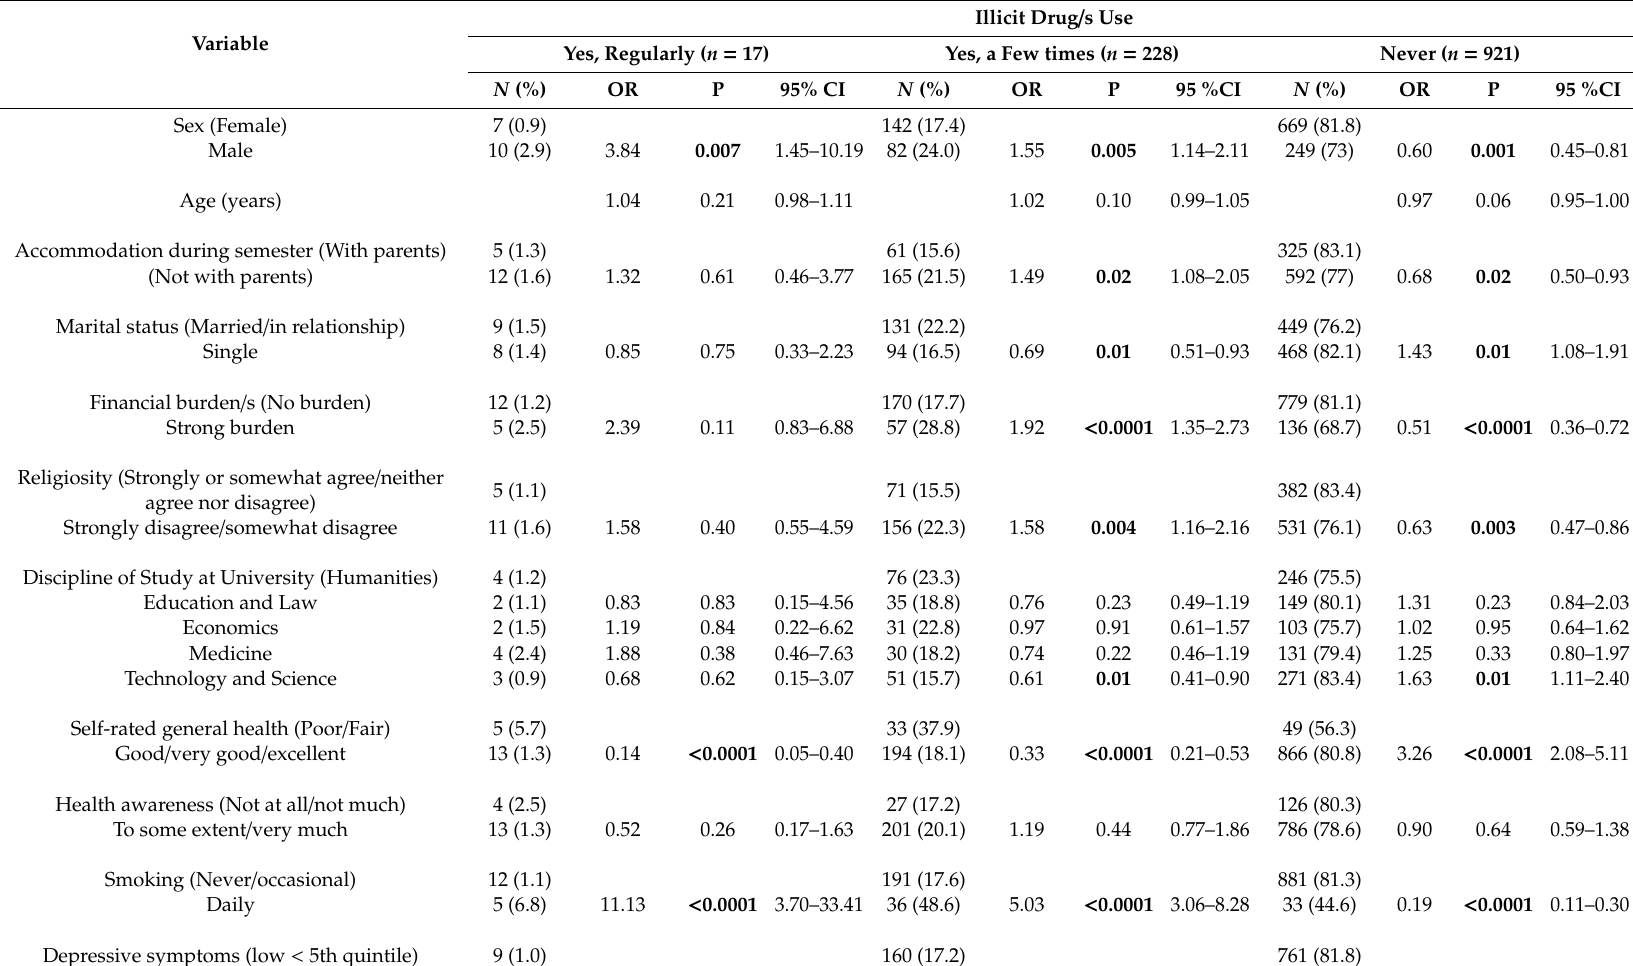
Table 2. Illicit drug / s use by selected variables among university students in Finland (bivariate